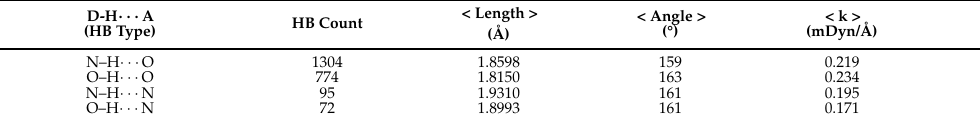
Table 2. Average hydrogen bond length, angle, and local force constant for each HB type in the database B. Database B comprised of ca. 400 experimental protein–ligand complexes and ca. 2200 protein–ligand hydrogen bonds with their geometries and strengths. Experimental PDB IDs for database B can be found in the Supplementary Materials under the topic of PDB IDs for database